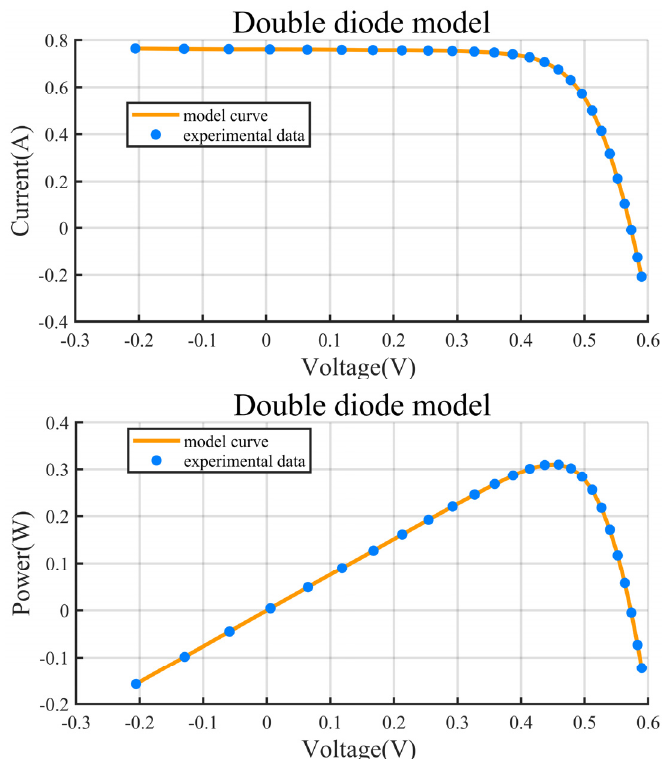
Figure A2. Comparisons between the experimental data and simulated data obtained by IMFO for double diode model: I ‐ V and P ‐ V characteristics.